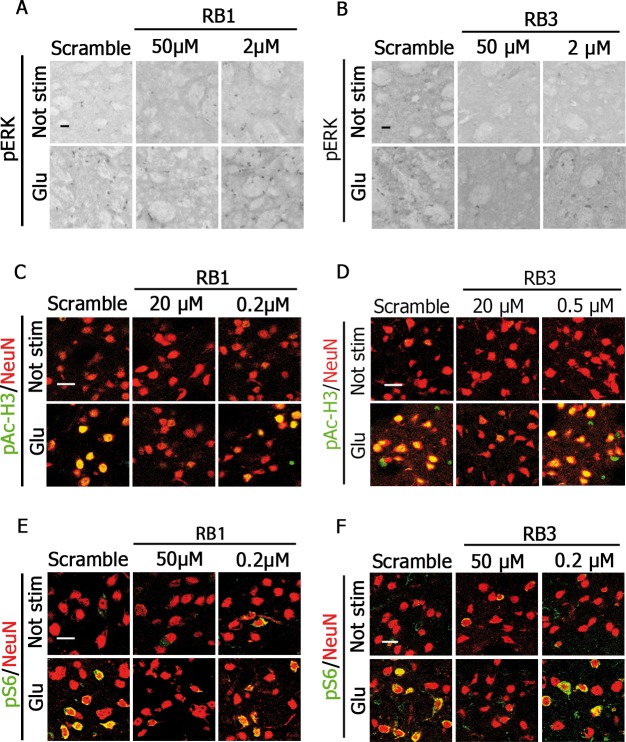
RB1 and RB3 show a dose-dependent inhibition of ERK activation and its substrates H3 and S6.The highest doses of RB1 and RB3 prevented glutamate-induced ERK activation (A,B, scale bar 100 µm), H3 activation (C,D scale bar 30 µm) and S6 activation (E,F scale bar 30 µm), whereas the lowest doses of RB1 and RB3 failed to inhibit ERK, H3 and S6.